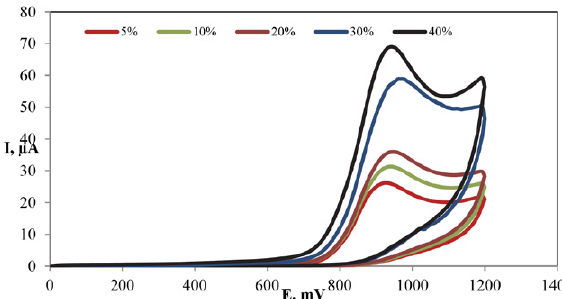
Figure 5. Cyclic voltammograms of SLC (1.0 mM) in PH 7.0 at car- bon paste electrode containing different amounts of sephadexL;